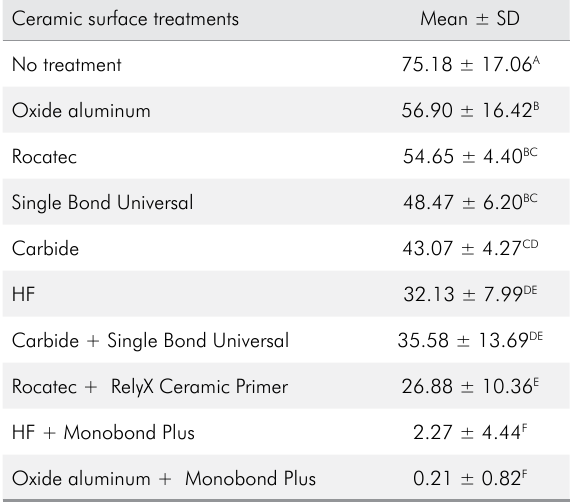
Table 4. Mean values (µm) and standard deviations (SD) of roughness data from Tukey’s